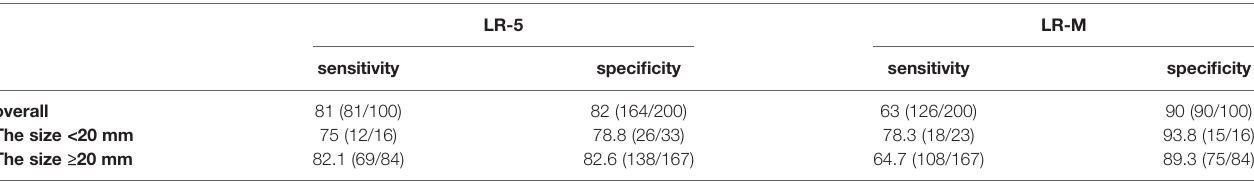
Data in parentheses were used to calculate percentages. LI-RADS, Liver Imaging Reporting and Data